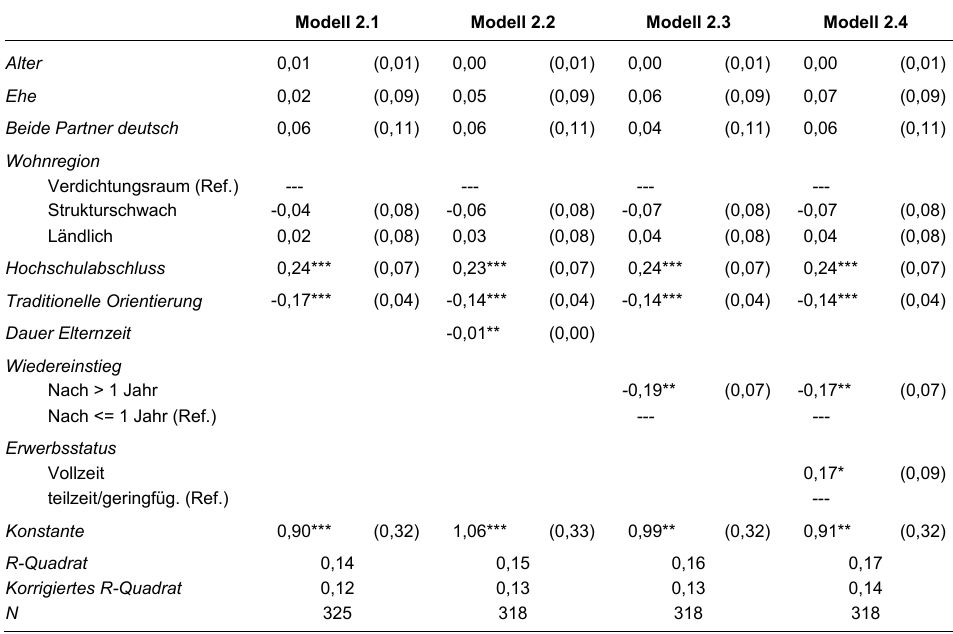
Tabelle 2: Ergebnisse der linearen Regression zur Hausarbeitsteilung – nur für Frauen, die nach der Elternzeit wieder erwerbstätig